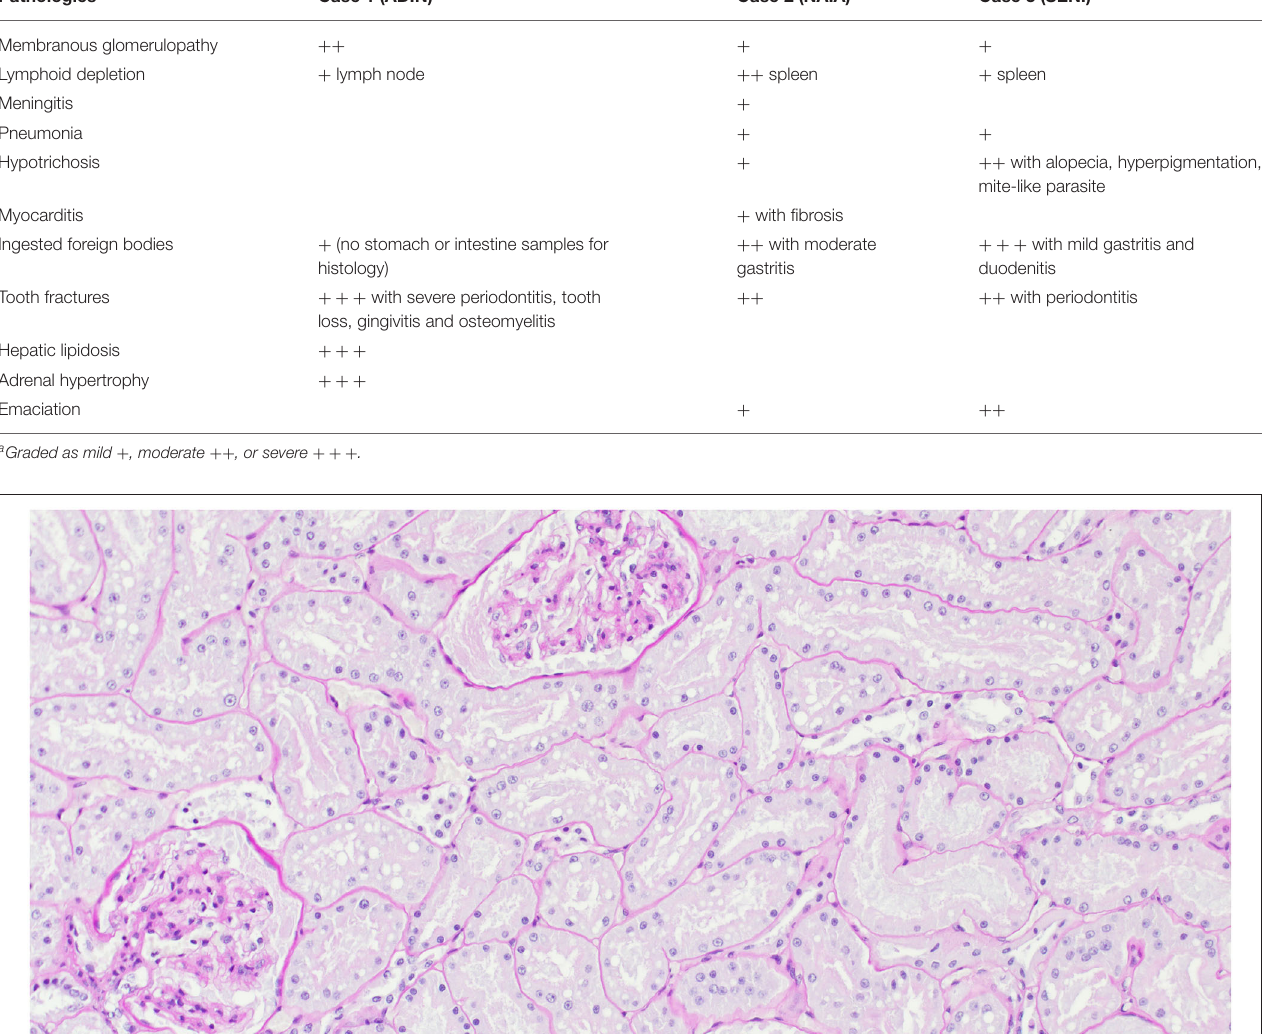
TABLE 4 | Pathological findings including macroscopical and histological diagnoses of the three FIV-seropositive Eurasian lynx ( Lynx lynx ). Empty cells: not detected. Pathologies a